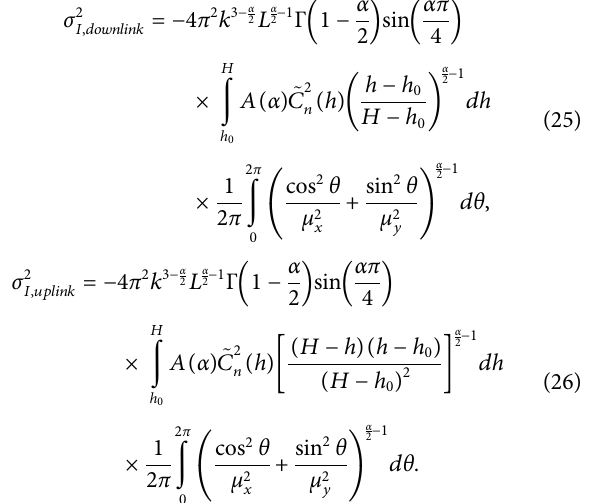
Figure 3 ; Figure 4 present the variation of the scintillation index for the downlink and uplink against the function of the anisotropic tilt angle γ under different anisotropic factor μ and power law α values. It is to be noted that in the calculation, we ( 0 ) (cid:1) 1 × 10 − 14 m − 2/3 , h have λ = 1.55 μ m, L = 1,000 km, C 2 0 = n 0 m, and w = 30 m/s. As displayed in Figure 3 ; Figure 4 , for different values of power law α and anisotropic factor μ , the scintillation index for the downlink and uplink fi rst increase and then decay with the rising of the anisotropic tilt angle γ , and the curves are symmetric about the straight-line γ = 90 ° , so the anisotropic tilt angle γ is necessary in the vertical link.